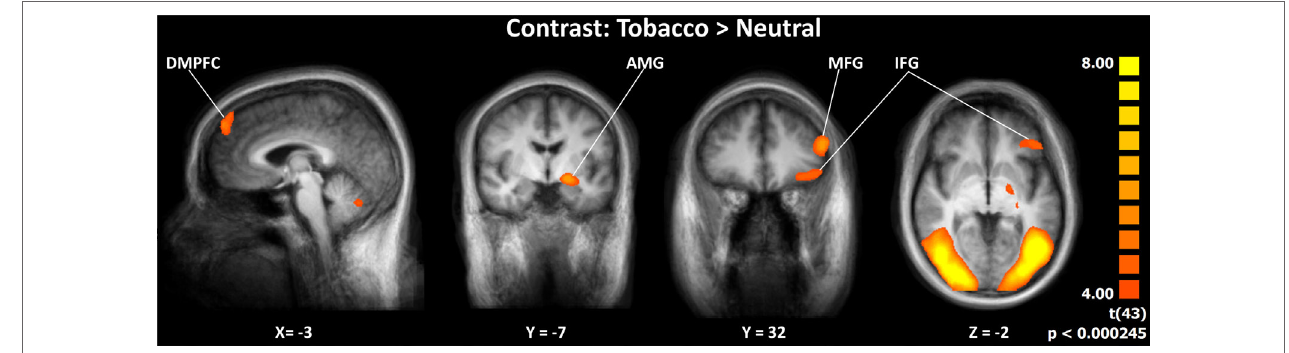
FigUre 2 | Activation specific to aversive smoking-related images across groups. Abbreviations: DMPFC, dorsomedial prefrontal cortex; AMG, amygdala; MFG, middle frontal gyrus; IFG, inferior frontal gyrus. Images displayed in radiological